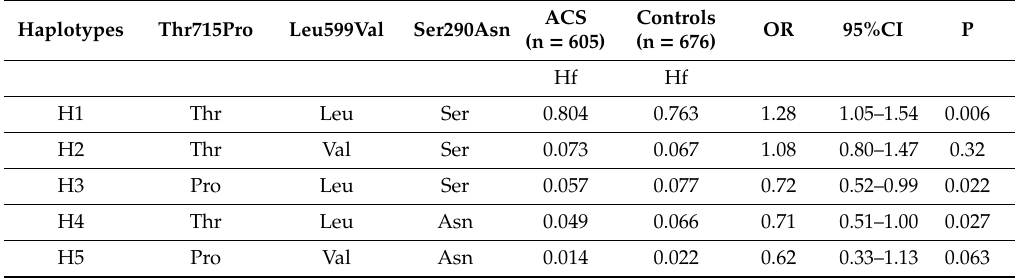
Table 3. Haplotype frequencies (Hf) of SEL-P haplotypes in ACS patients and healthy controls.